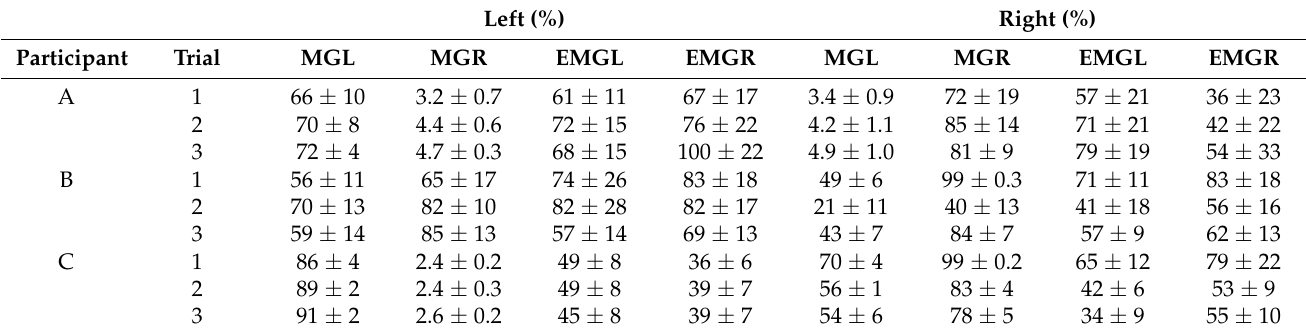
Table 3. MG sensor and EMG results during left and right movement.